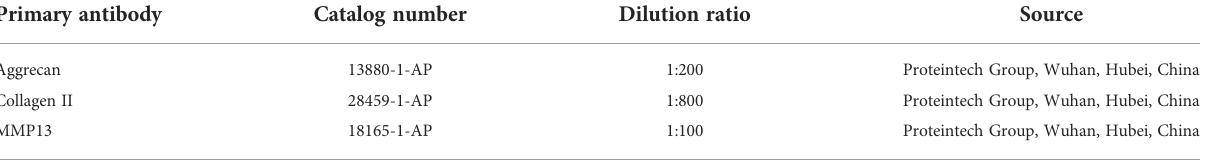
TABLE 3 Primary antibodies for IHC